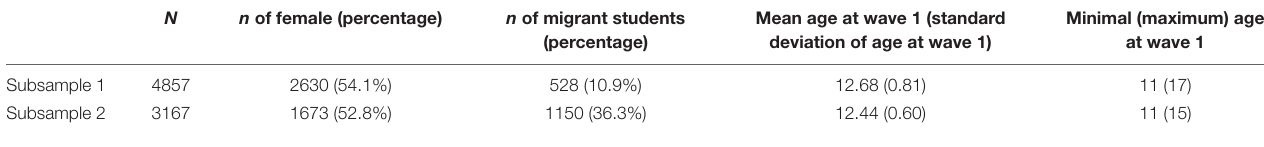
TABLE 1 | Demographic information and migrant status for the two subsamples. N n of female (percentage) n of migrant students